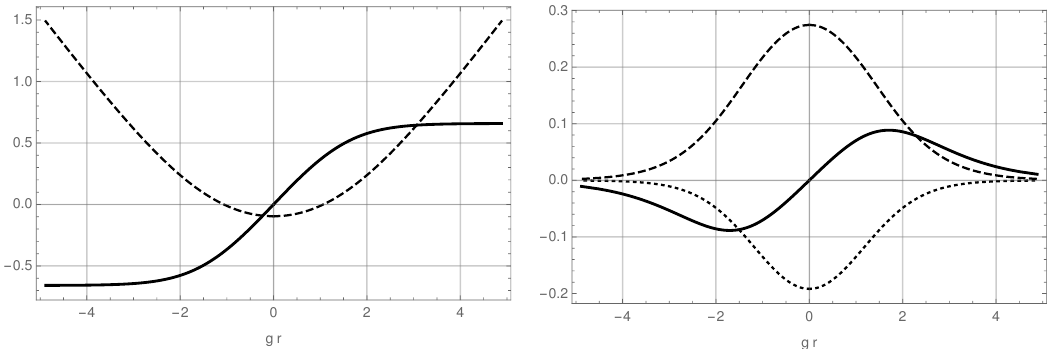
Figure 3. A sample solution with I = 1 = 3 . On the left pane we plot the functions F ( r ) (cid:0) F 0 (solid curve) that controls the solution for ’ and the warp factor A shifted by a constant value (dashed curve). On the right pane we plot (cid:21) (solid curve), (cid:31) (dashed curve), and 8 (cid:11) (dotted